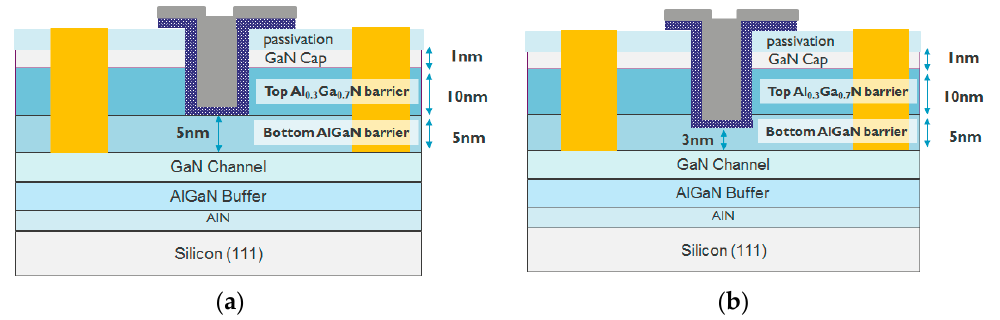
Figure 4. Schematic of device structures of recessed gate AlGaN/GaN MIS-HEMTs with a 5 nm remaining bottom AlGaN barrier under the gate region ( a ) and a 3 nm remaining bottom AlGaN barrier under the gate region ( b ).